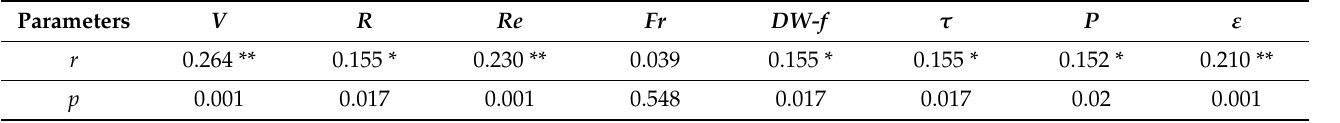
Table 2. The effect of different flows on hydraulic